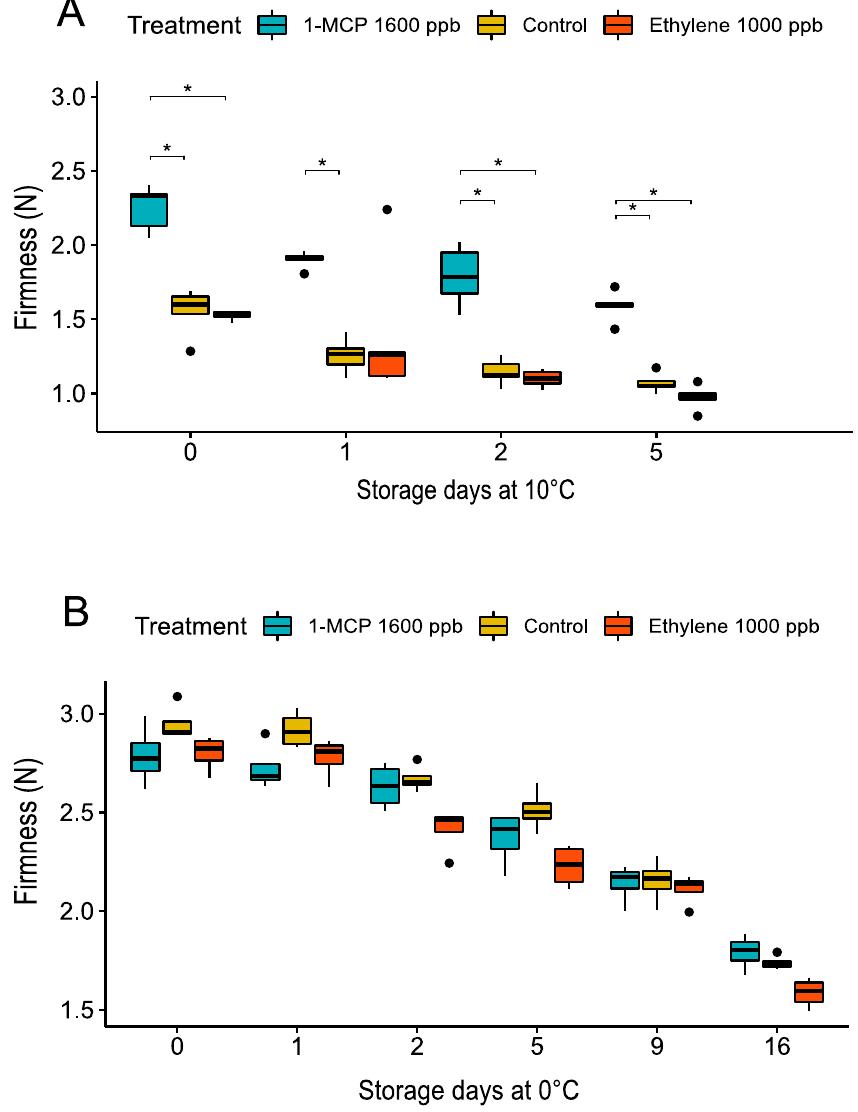
Figure 8. The firmness of raspberry ( Rubus idaeus ‘Heritage’) fruit during treatment with ethylene and 1-methyl cyclopropane (1-MCP). The storage assay was performed at the W stage of raspberry fruit and stored for 5 and 16 days at 10 ◦ C ( A ) and 0 ◦ C ( B ), respectively. Firmness (N) was determined for ethylene and 1-MCP-treated fruits and controls. Data represent the means ± S.D. from five sample units (each containing ten fruits). Asterisks indicate significant differences between treatments at the same storage time ( p ≤ 0.05). Boxplots show each group’s distribution (treatment) and the black line (central value in the box) signs the median value. Points out of the boxplots show outlier values.